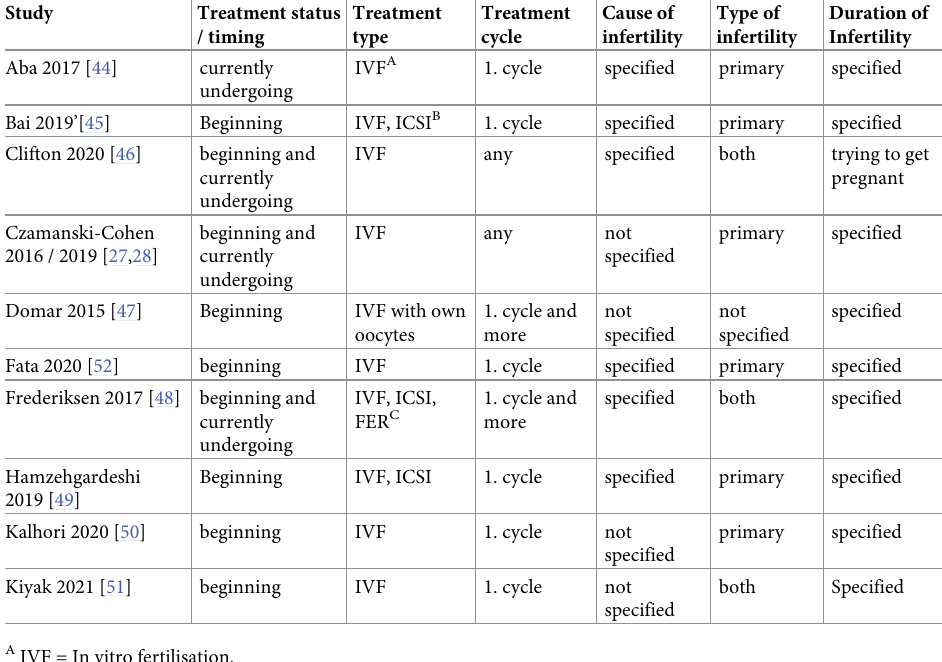
Table 3. Information about ART treatment and infertility.